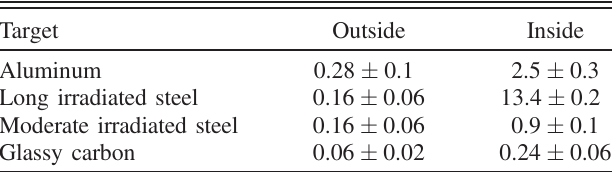
TABLE I. The surface roughness inside and outside the irradiation